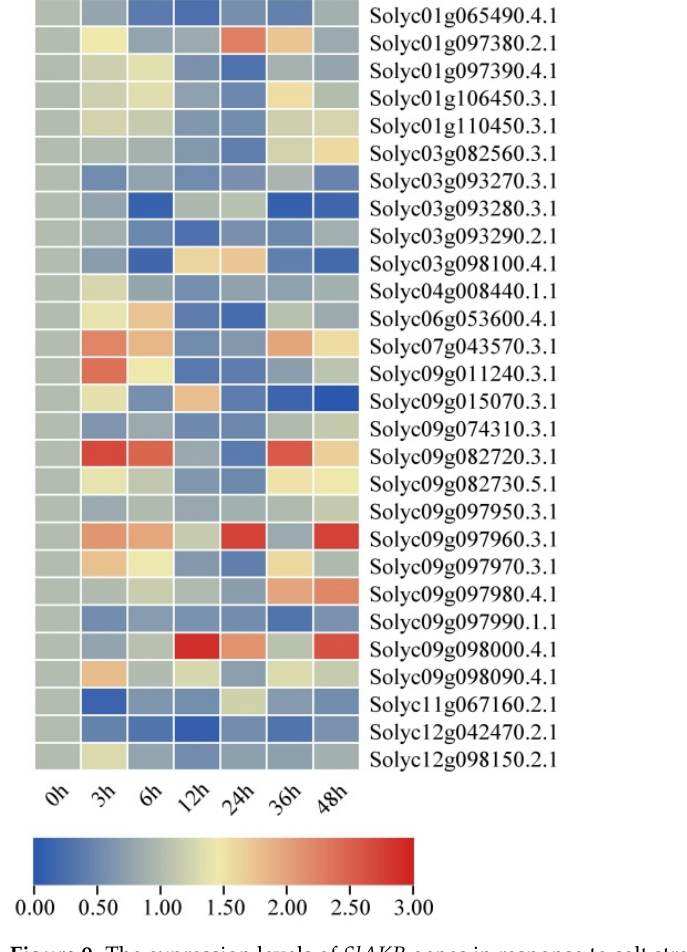
Figure 9. The expression levels of SlAKR genes in response to salt stresses treated with 200 mM NaCl for different times, such as 0, 3, 6, 12, 24, 36, and 48 h, with dd H 2 O as a control in AC.